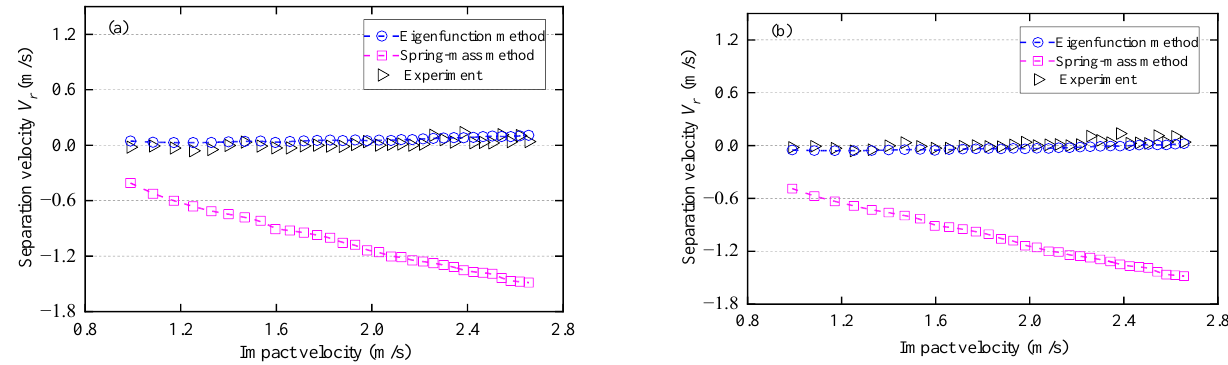
Figure 15. Comparison of separation velocity of the sphere: ( a ) KK model; ( b ) KE model.